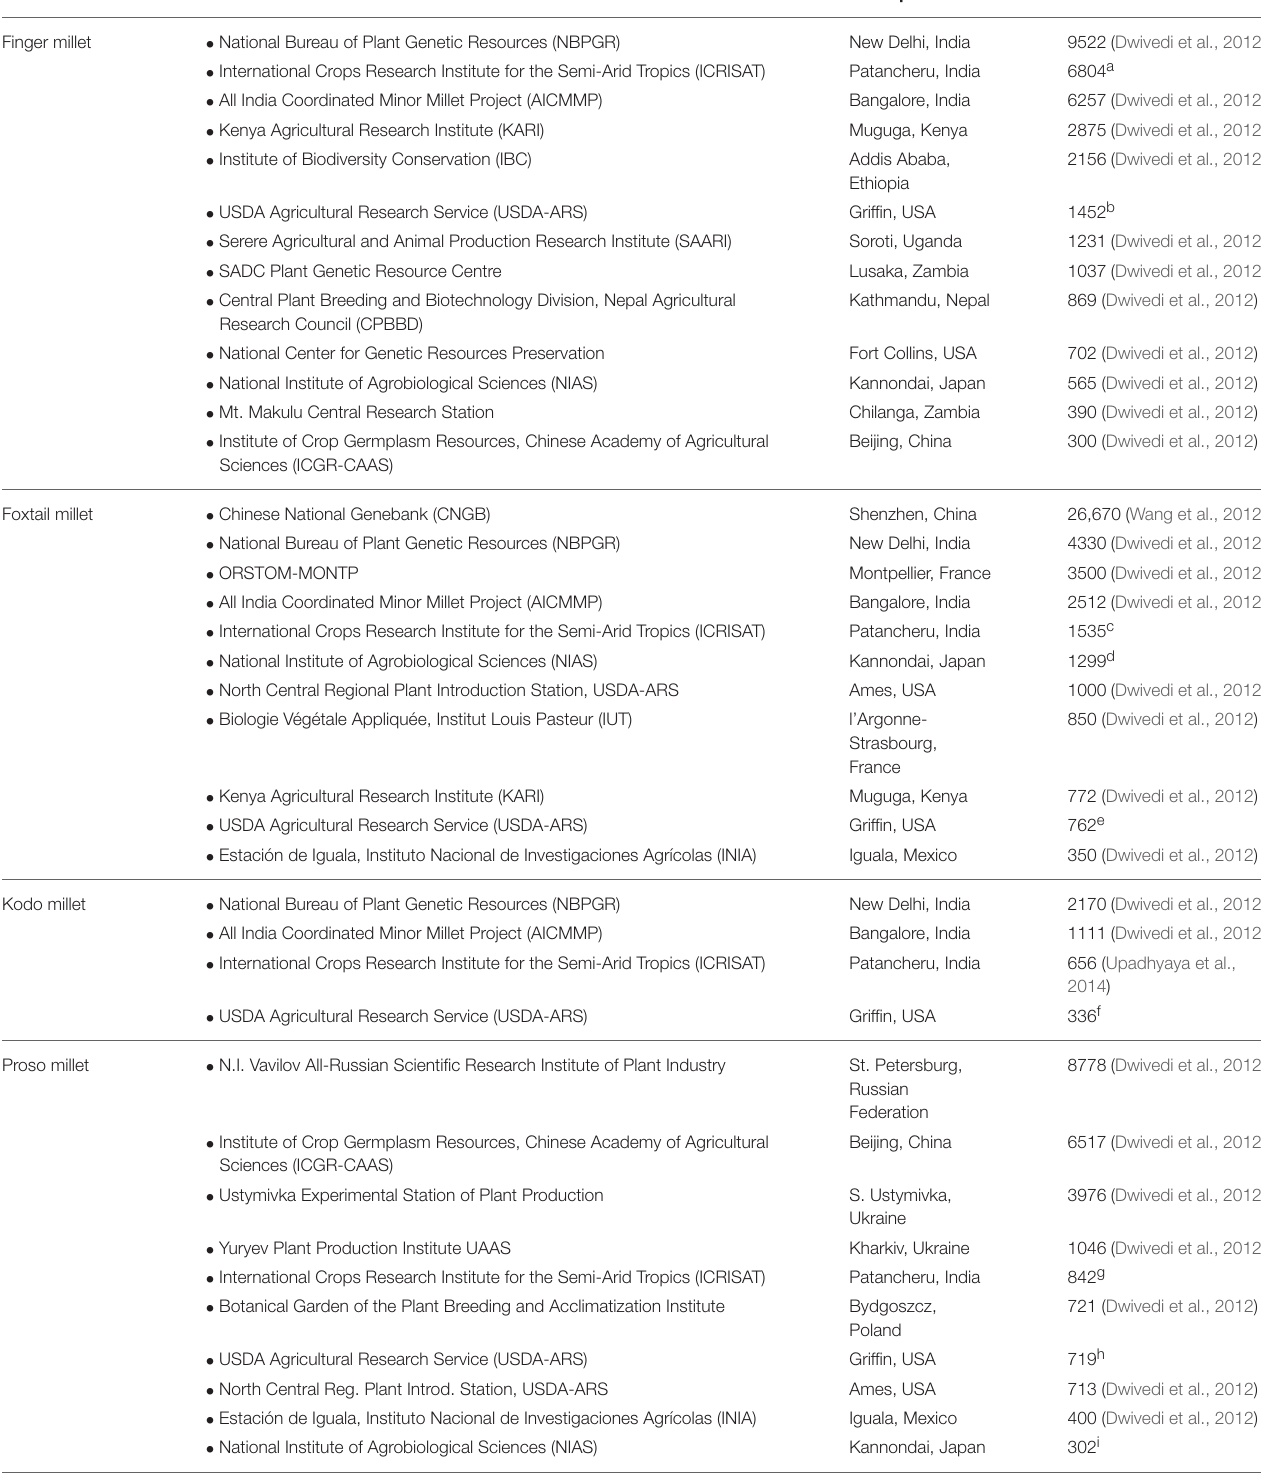
TABLE 2 | Significant germplasm collections of the small